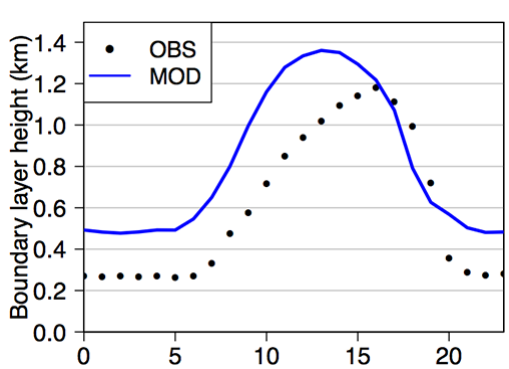
Figure 5. Boundary layer height diurnal profile at SIRTA station, measured (in black) and simulated (in blue) during the PARTIC- ULES campaign